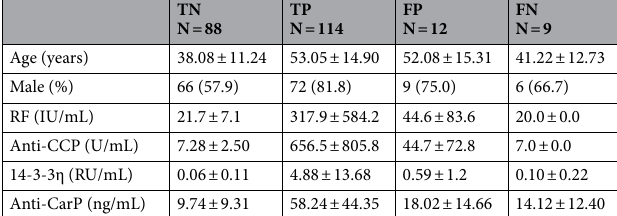
Table 5. Basal characteristics of 4